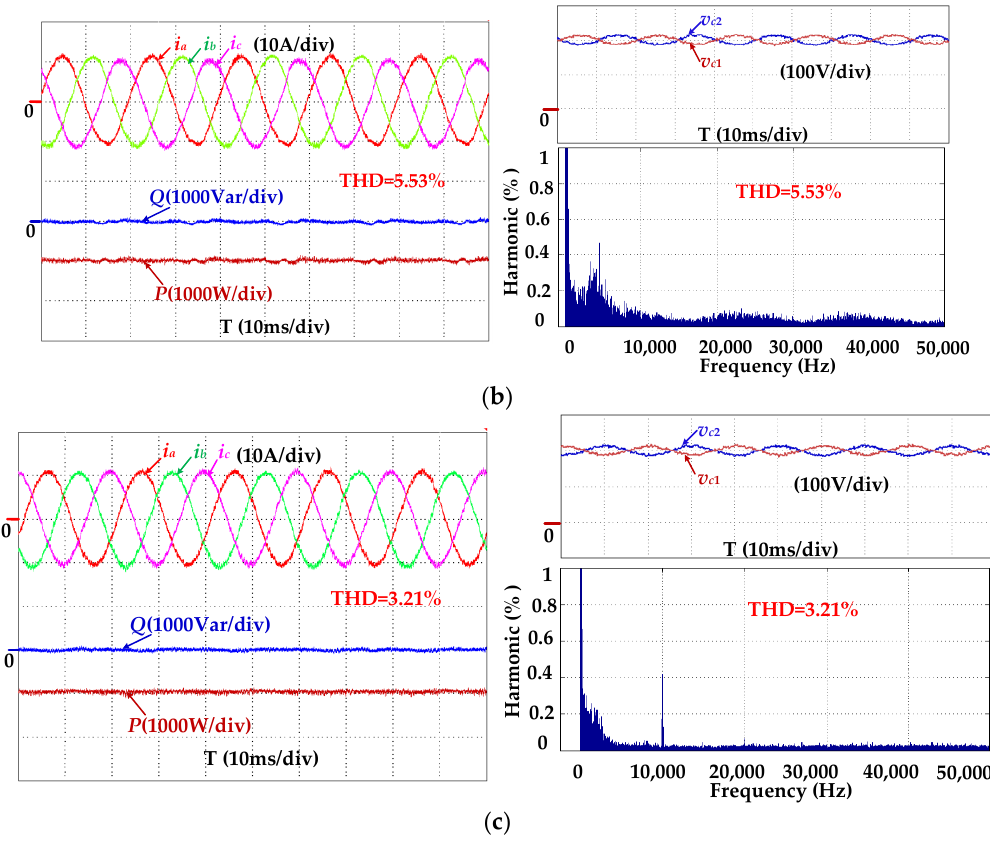
Figure 13. Experimental results of BVSC with a Phase A fault in rectifier mode. ( a ) MPDPC for BVSC. ( b ) MPDPC for a TPFS converter. ( c ) Proposed CF-MPDPC for a TPFS converter. Table 4. Experimental comparison of current THD.